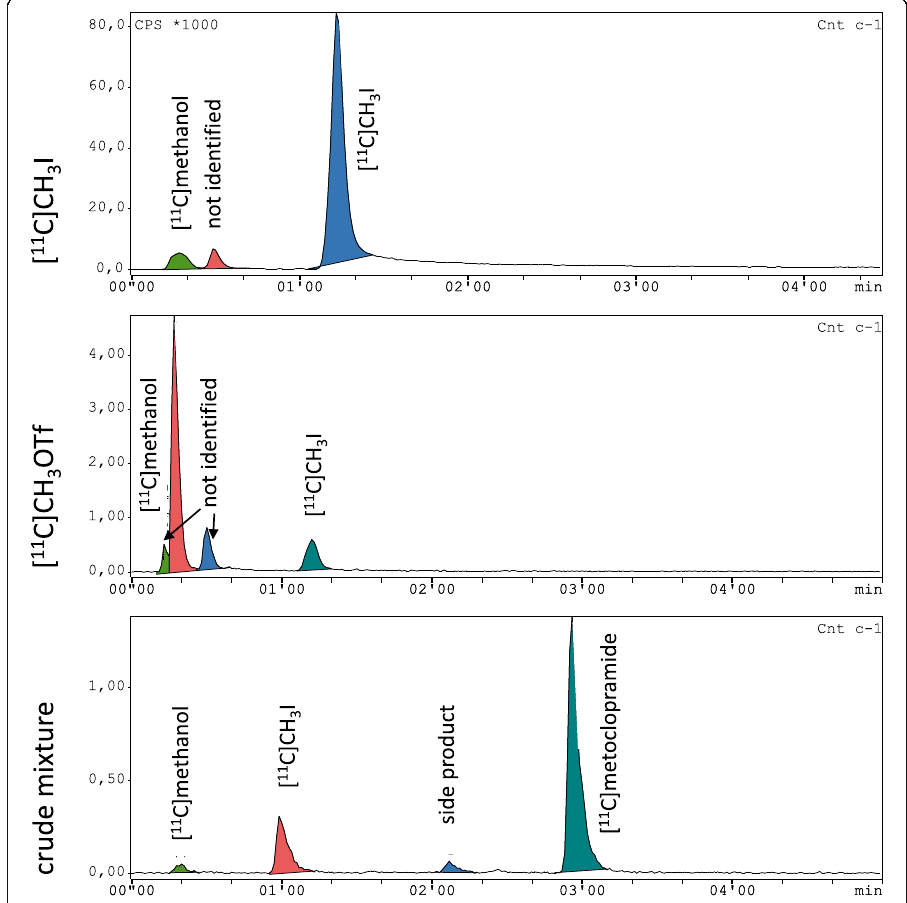
Fig. 8 Radio-HPLC analysis of [ 11 C]CH 3 I, [ 11 C]CH 3 OTf and crude reaction mixture. The individual peaks